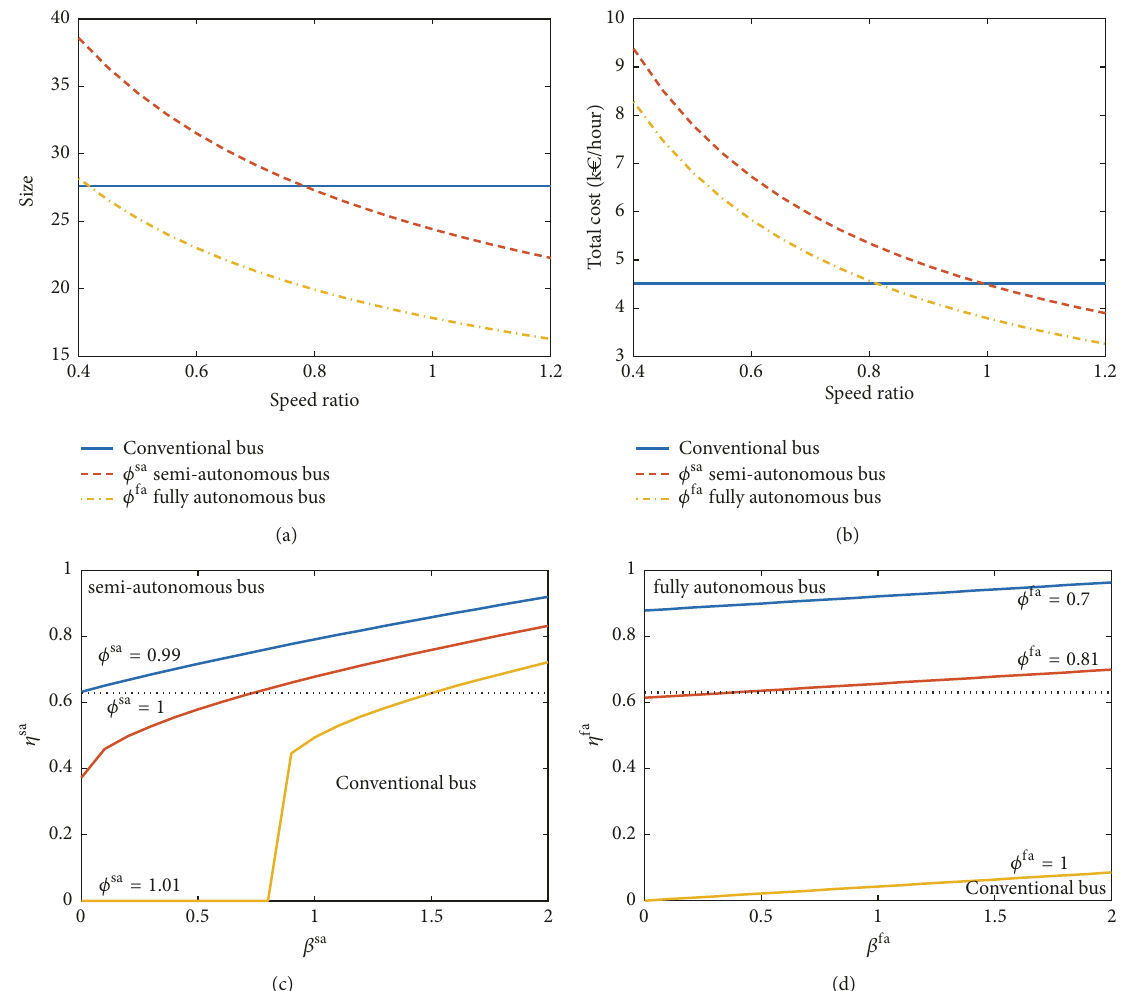
Figure 8: (a) Size, (b) total cost, (c) applicability of semi-autonomous buses, and (d) applicability of fully autonomous buses as functions of 𝜙 sa and 𝜙 fa . Note that the top-left side of each curve in (c) and (d) indicates the preferable region of semi-autonomous (fully autonomous) bus, whereas the other side is for conventional bus. The dotted line gives the upper bound of 𝜂 sa , which is 0.63. Other parameters according to Table